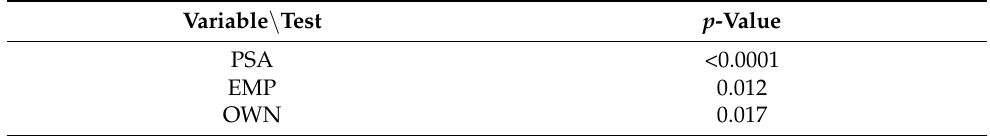
Table 5. Kruskal–Wallis test according to the extent of the ethics code.